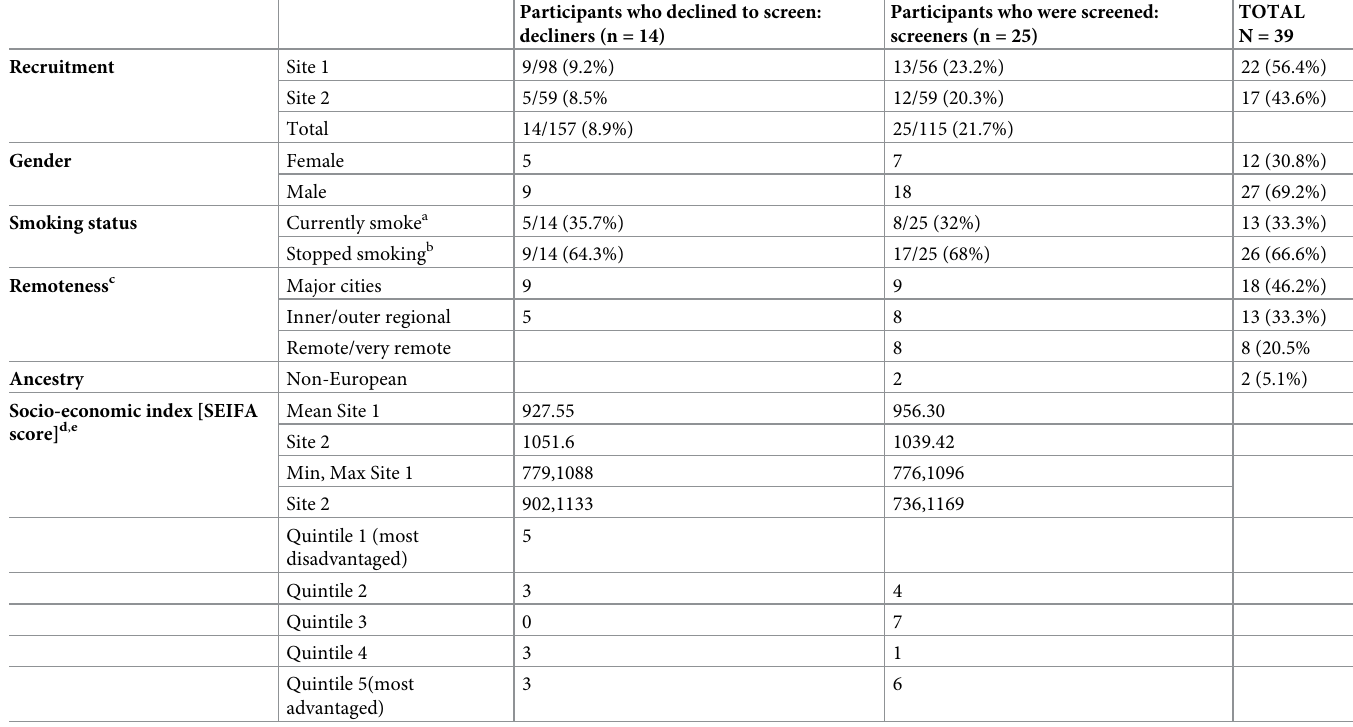
Table 1. Demographic characteristics of